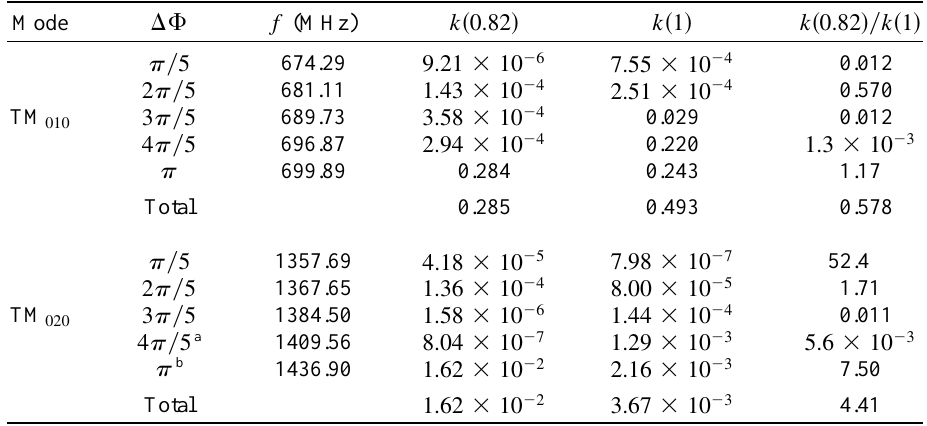
TABLE II. Loss factors (in V (cid:121) pC) of the lowest modes in the APT 5-cell b (cid:173) (cid:48)(cid:46)(cid:56)(cid:50) cavity. Mode